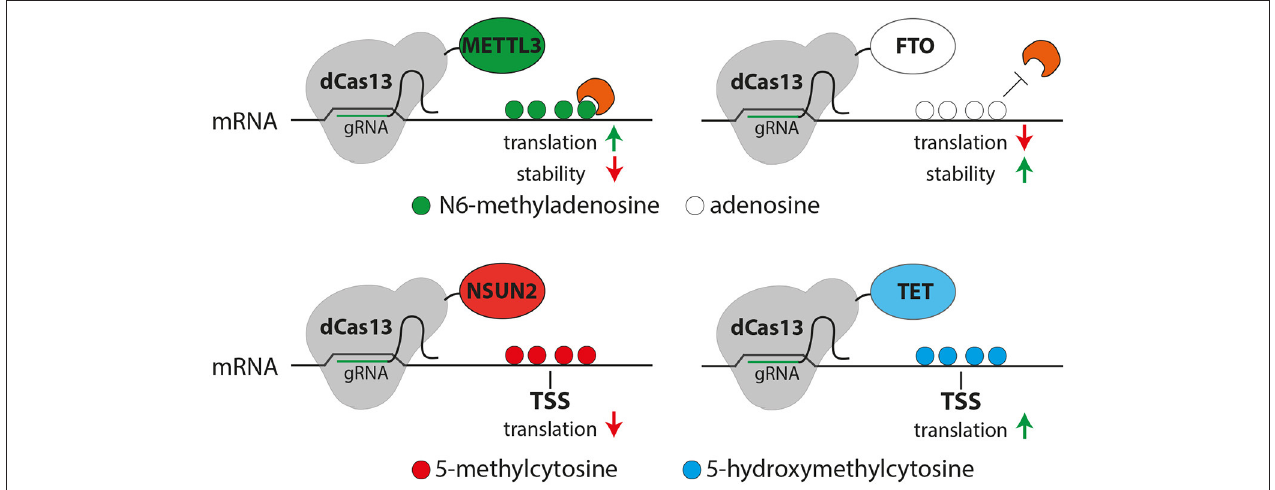
FIGURE 2 | Possible uses of the CRISPR-dCas13 (gray) system for epitranscriptome editing of N6-methyladensosine (m6A, top) or 5-methylcytosine (5mC, bottom). Top: Fusing dCas13 together with METTL3 (green) or FTO (white) may allow the site and transcript specific methylation (green) or demethylation (white) of mRNA, respectively resulting in m6A-mediated changes in translation or RNA stability (red or green arrows). Bottom: methylation of cytosine (red) or oxidation of 5mC (blue) of cytosine can be triggered by dCas13 fusion to NSUN2 (red) or TET (blue), respectively potentially resulting in a decreased (red arrow, left) or increased (green arrow, right)